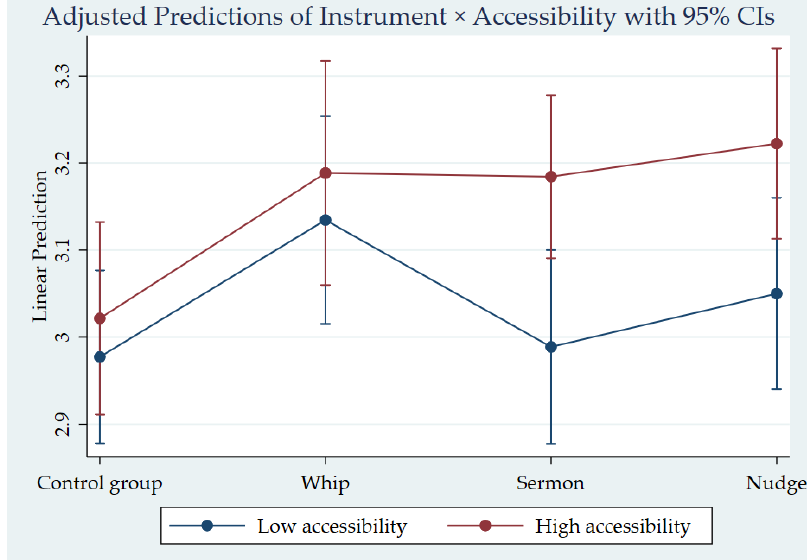
Figure 2. The effectiveness of the policy